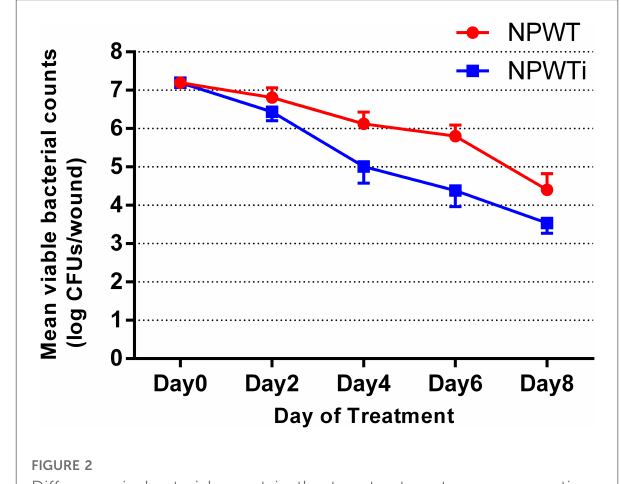
FIGURE 2 Difference in bacterial count in the two treatment groups over time ( N =3).